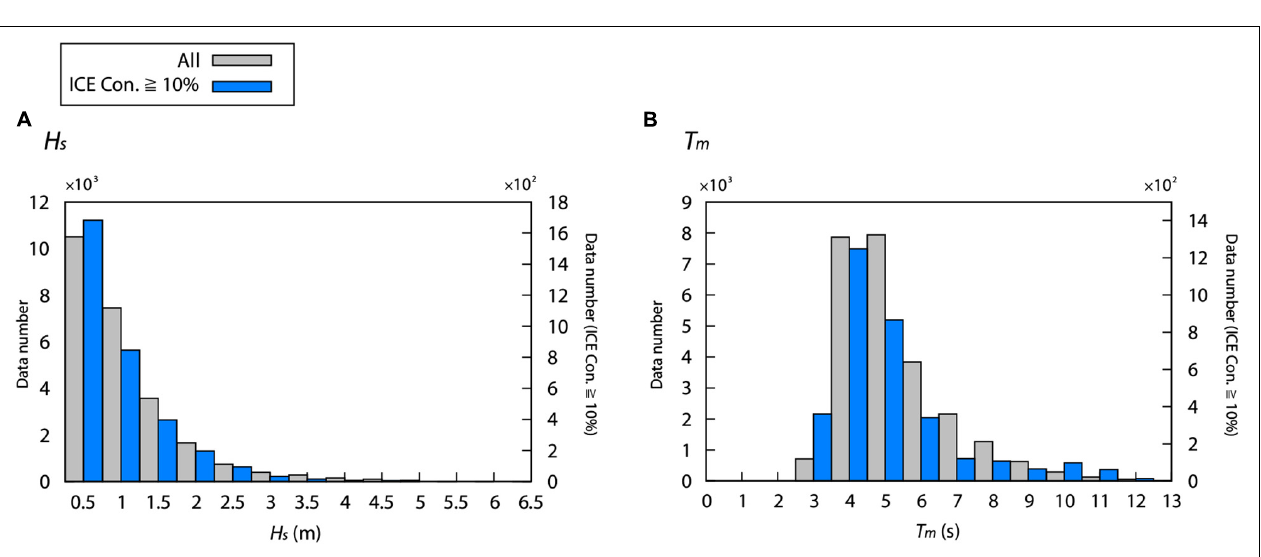
FIGURE 2 | Frequency distribution of hourly (A) H s and (B) T m from the NOWPHAS buoy. Gray bars correspond to values for all data during 2008–2010, while blue bars indicate data for the ice- covered condition. Intervals ( X –axis) of H s and T m are (A) 0.5 m and (B) 1 s, respectively.